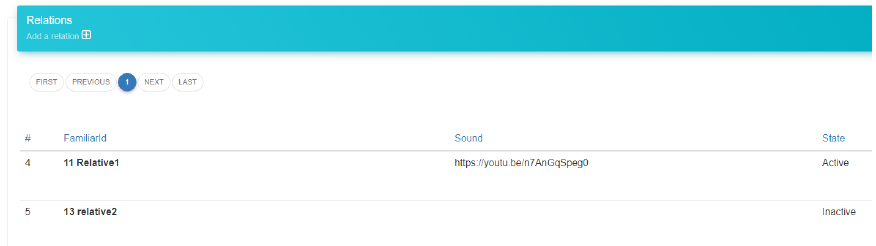
Figure 6. Sufferer (administrator) dashboard.